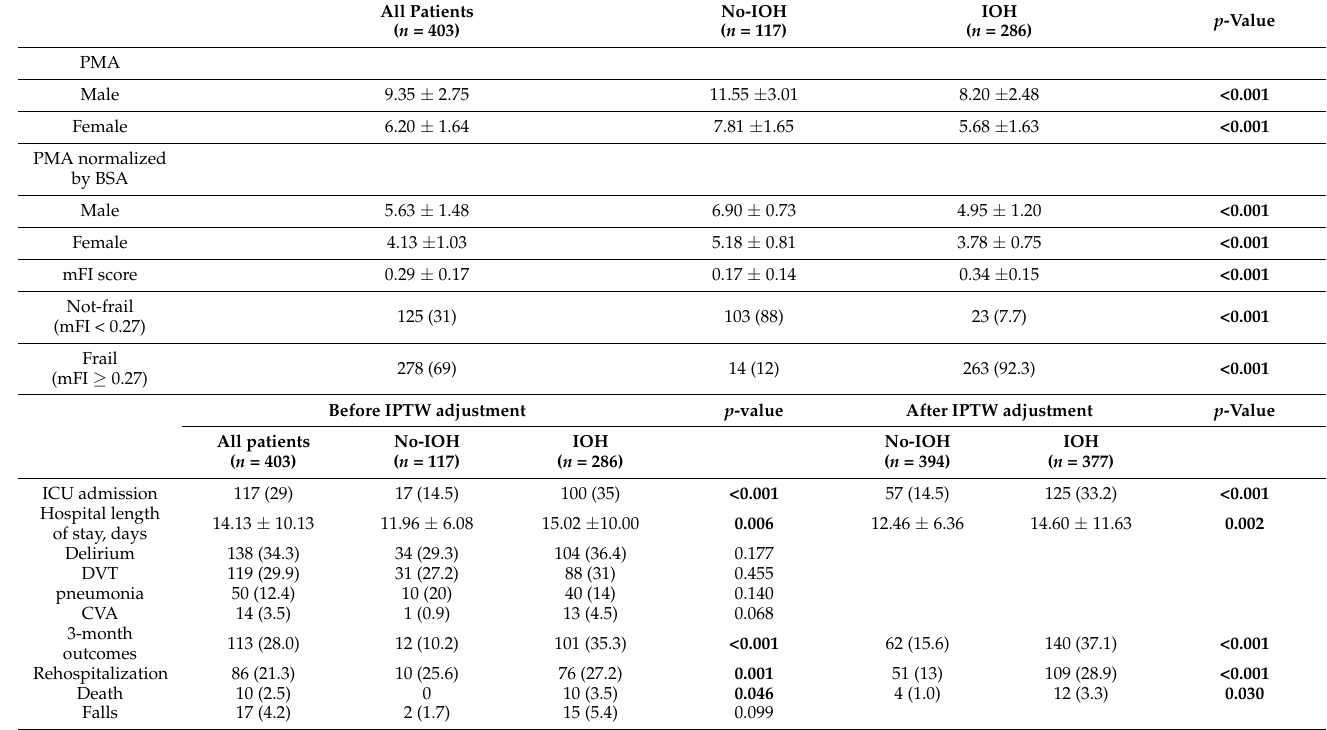
Table 2. Patients’ frailty assessment and postoperative 3-month outcomes before and after IPTW. All Patients ( n =